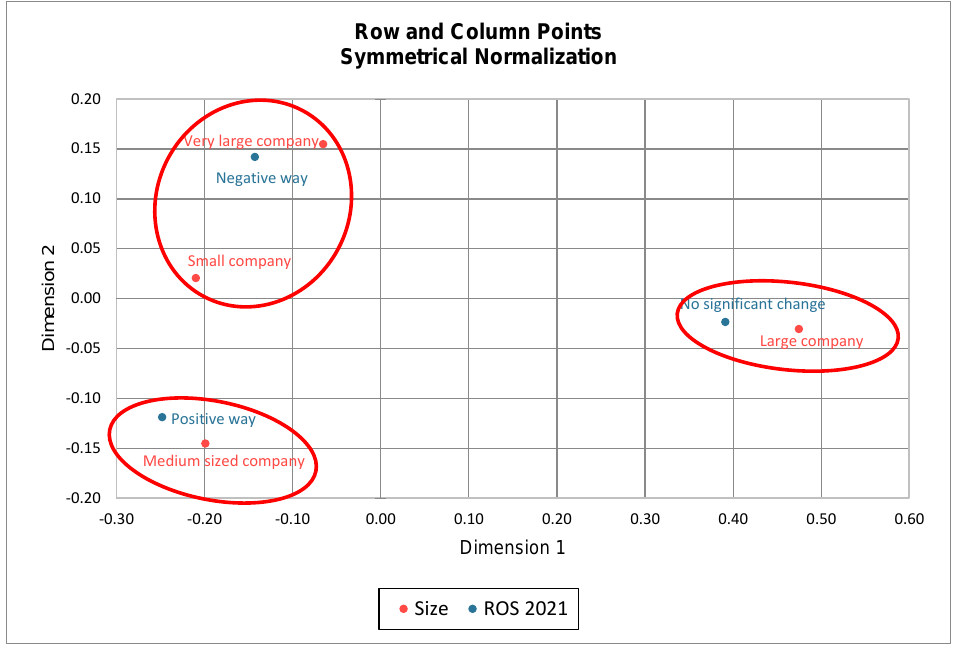
Figure 14. Correspondence map for ROS indicators in 2021 and enterprise size categories. Source: own research. Table 25. The resulting classification of enterprise size categories is based on their performance with respect to the selected profitability indicators for the period covered. Source: own